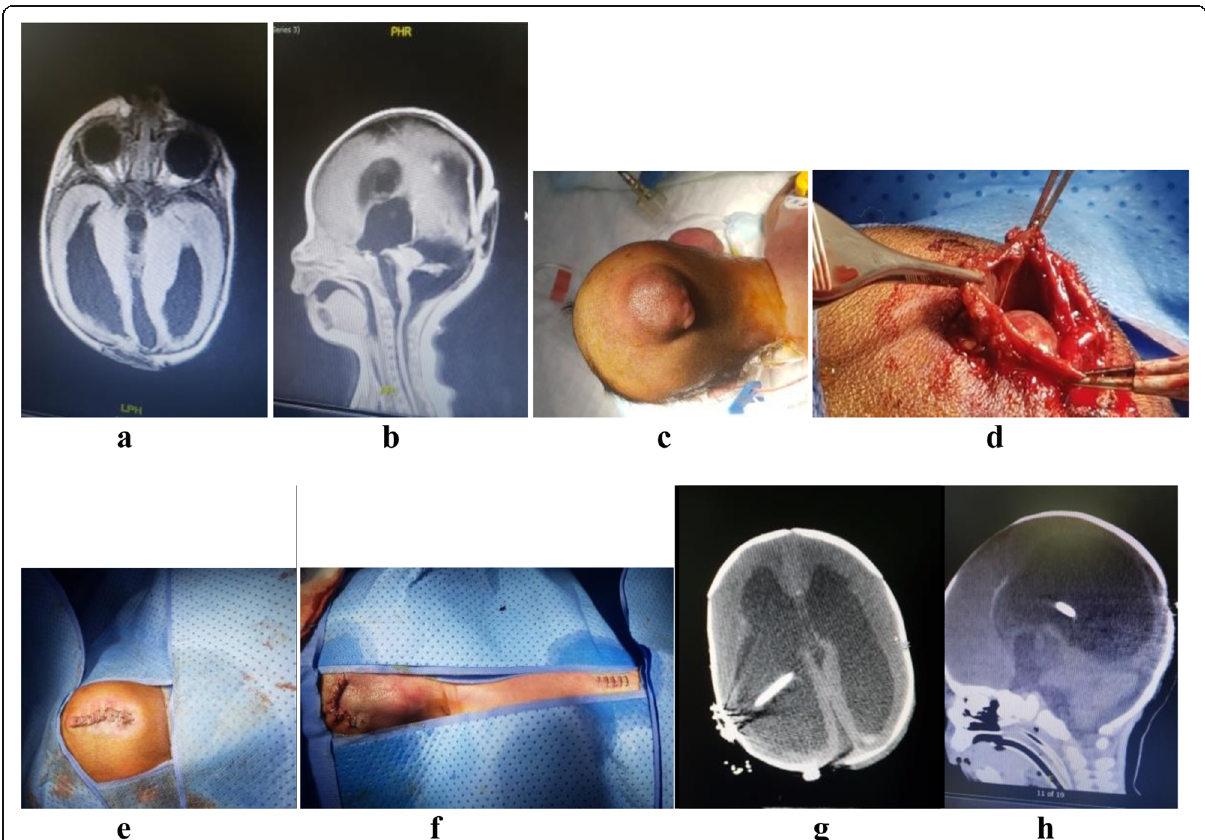
Fig. 1 A 10-day boy. a , b Axial and sagittal T1-weighted MRI brain showing occipital encephalocele with communicating hydrocephalus and Dandy – Walker malformation. c , d Intraoperative pictures showing that the encephalocele contained gliosed brain tissue. e , f Intraoperative pictures after repair of encephalocele and insertion of VP shunt. g , h Postoperative axial and sagittal CT brain showing the repaired encephalocele with the inserted VP